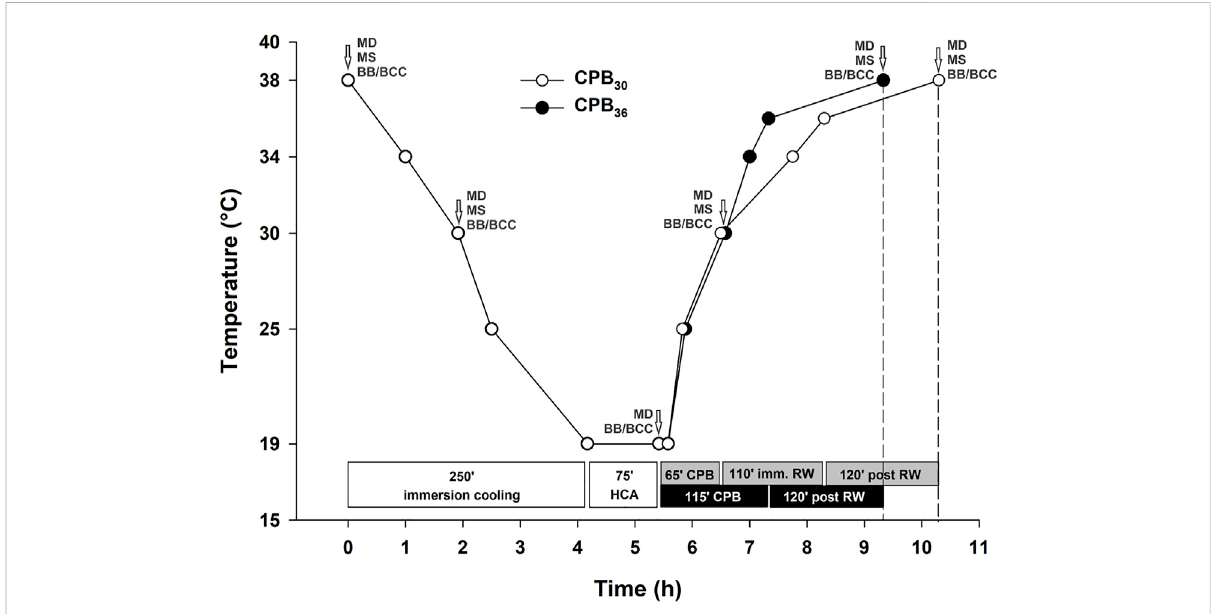
FIGURE 1 Experimental protocol. HCA – hypothermic cardiac arrest; CPB – cardiopulmonary bypass; RW – rewarming; imm. RW – immersion rewarming; MD – microdialysis; MS – microspheres; BB/BCC blood biochemistry/blood cells